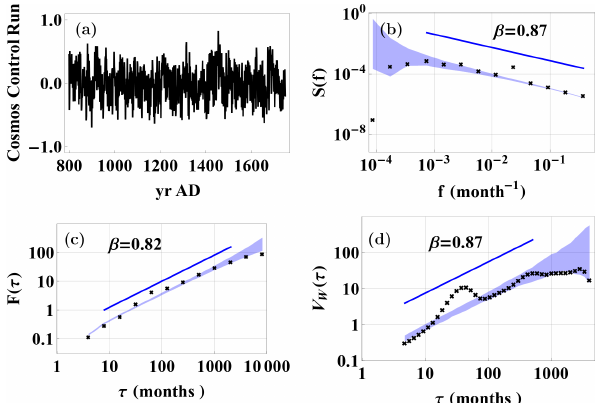
Figure 8. (a) Four-year average of the temperature from the COS- MOS experiment (black) and deterministic response (red). (b) The residual from the deterministic response. (c) PSD from the residual (black crosses) and linear fit to the PSD in the scale range indicated by the red line segment. The value β = 0 . 88 estimated from this line segment is indicated in the figure. (d) DFA2 applied to the residual (black crosses). The straight line segment is a linear fit to the dots in the range indicated by the length, and position of the line segment and the slope yields an alternative estimate β = 0 . 77 for the resid- ual, indicated in the figure. The shaded area in (c) and (d) is the 95% confidence range for synthetic fGn with β = 0 . 61 estimated by MLE using the response model.